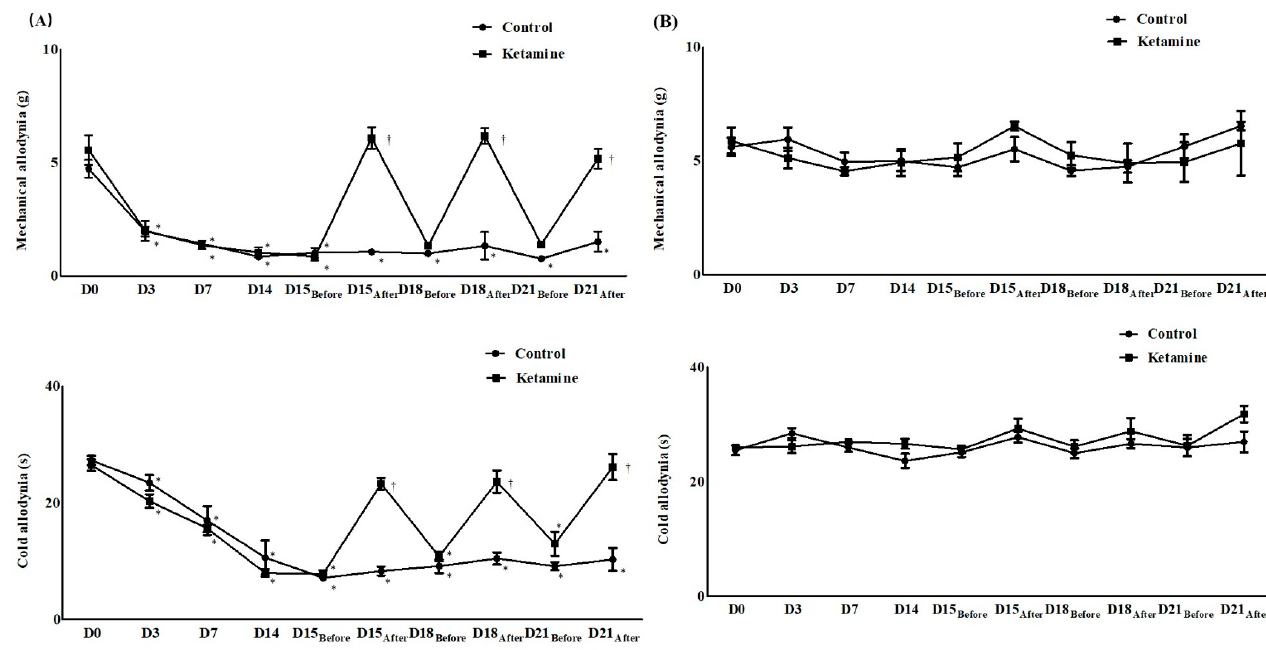
Figure 1. Assessment of allodynia for neuropathic pain before and after the treatment of ketamine or normal saline. ( A ) Ipsilateral side for the surgery and ( B ) contralateral side for the surgery. Abbreviations: control, control group; ketamine, ketamine group; D0, before the surgery; D, day after the surgery; before, before the treatment of ketamine or normal saline; after, 60 min after the treatment of ketamine or normal saline. * p < 0.05 compared with D0 in intra-group variance. † p < 0.05 compared with the control group.